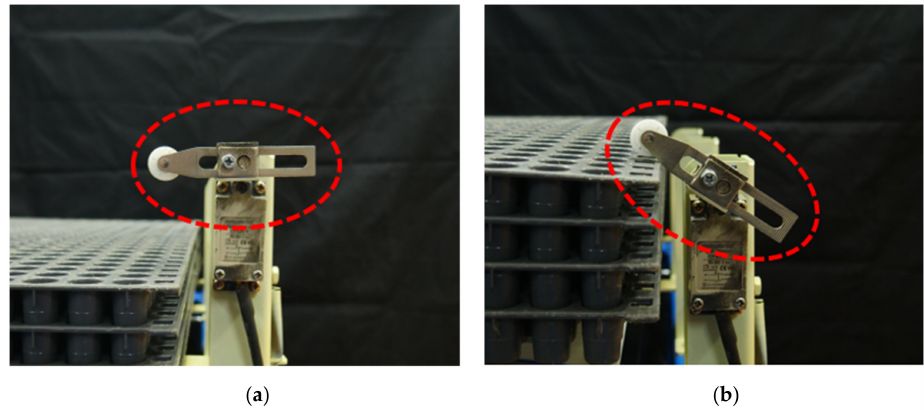
Figure 9. View of alarm bell: ( a ) noncontact situation and ( b ) contact situation of alarm bell with pot tray.